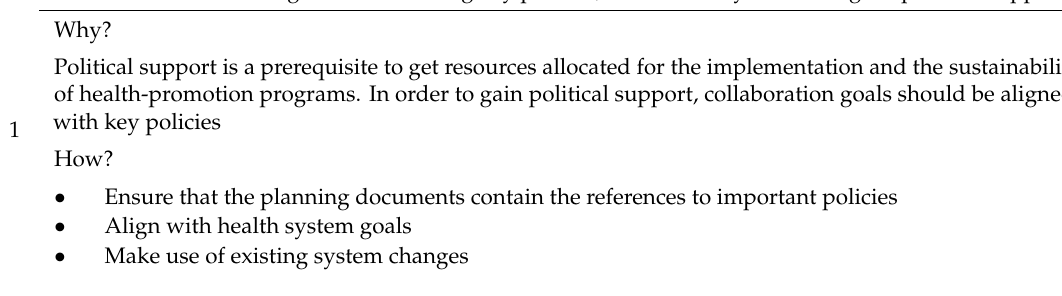
Table 3. Seven recommendations for e ff ective intersectoral collaboration with the rationale and steps to implement the recommendation (see Table S2 for a detailed table, with descriptions of the interventions that illustrate the implementation of the recommendation in